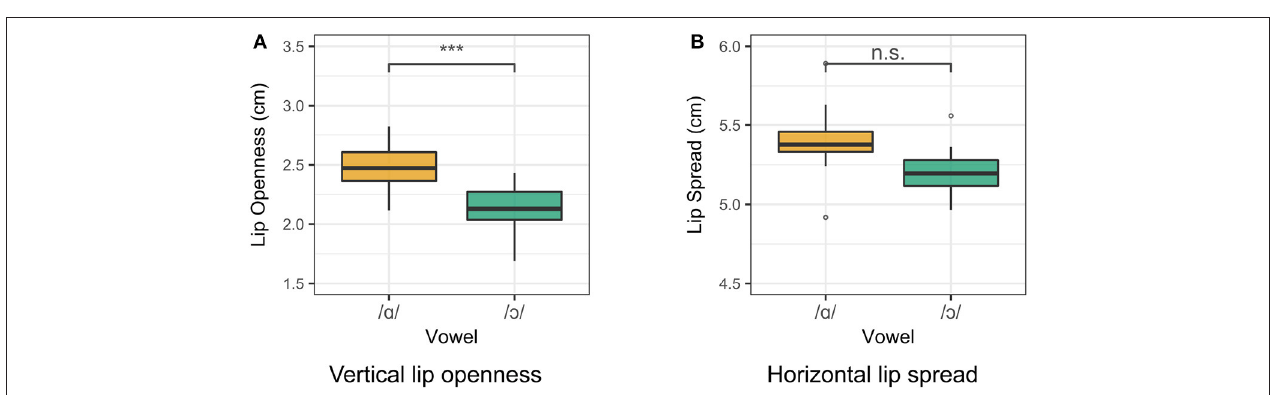
FIGURE 6 | Lip measurements for Speaker 4. Smaller measurements indicate a greater degree of lip rounding. (A) Vertical lip openness. (B) Horizontal lip spread.